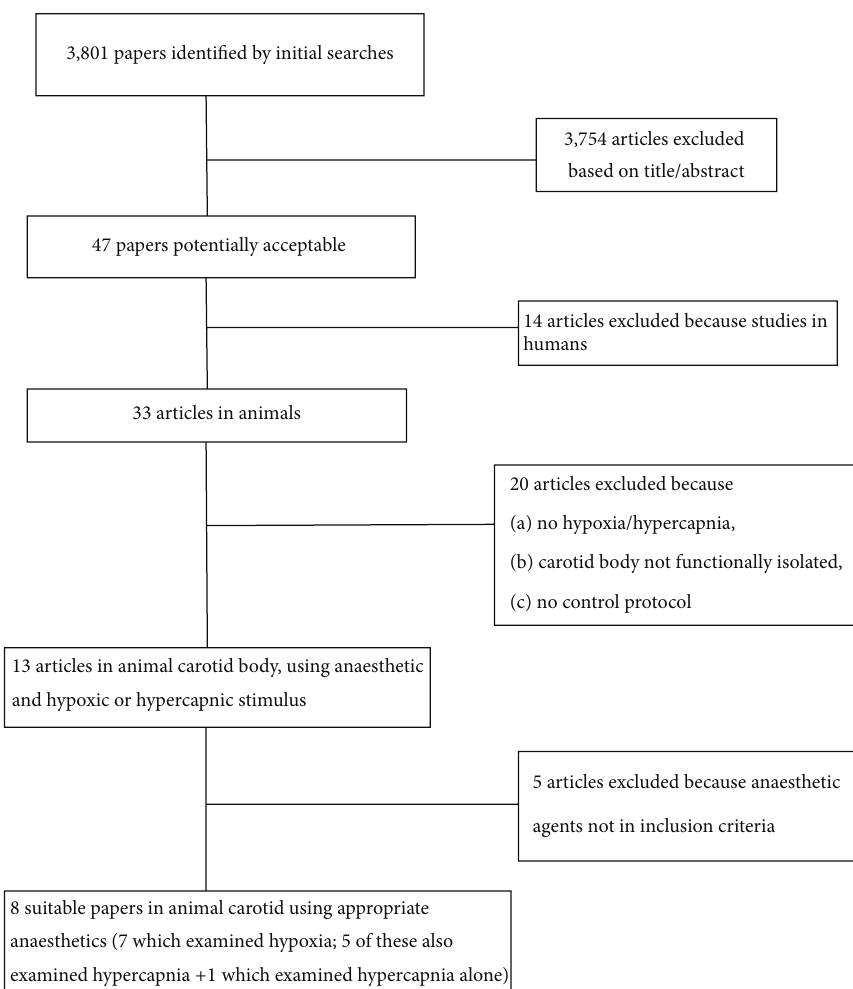
Figure 1: Flow diagram showing the selection of articles for